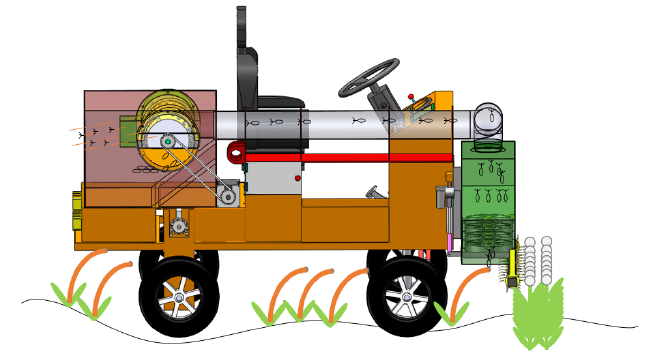
Figure 2. Harvest operation diagram.